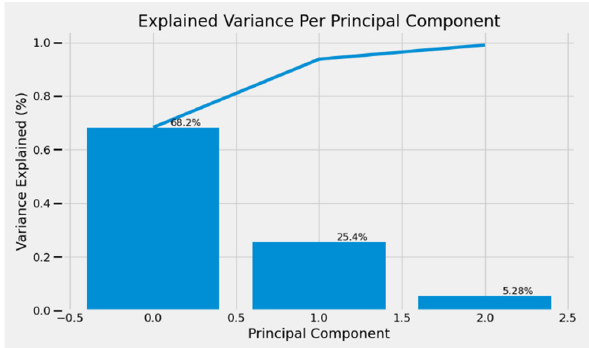
Figure 2. Total captured explained variance by each component.